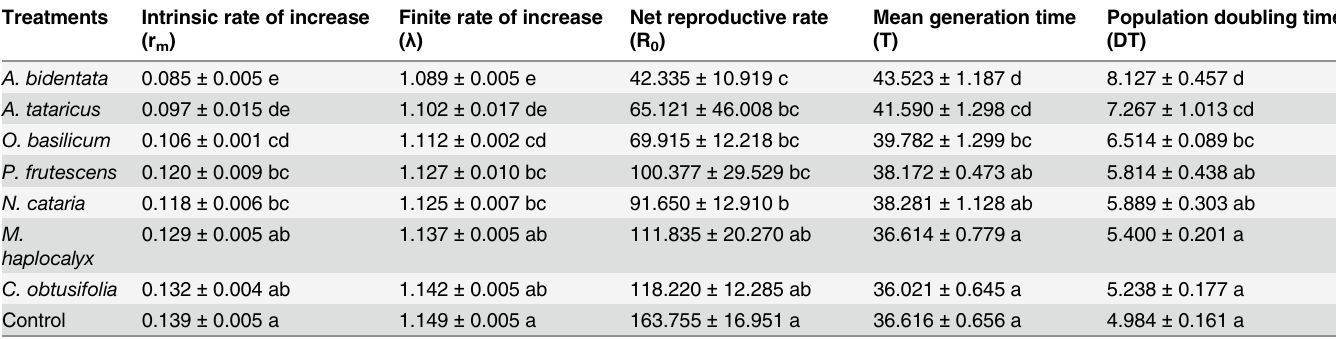
Table 3. Life table parameters (mean ± SE) of grape phylloxera treated by aqueous root extract of Chinese medicinal herbs. Treatments